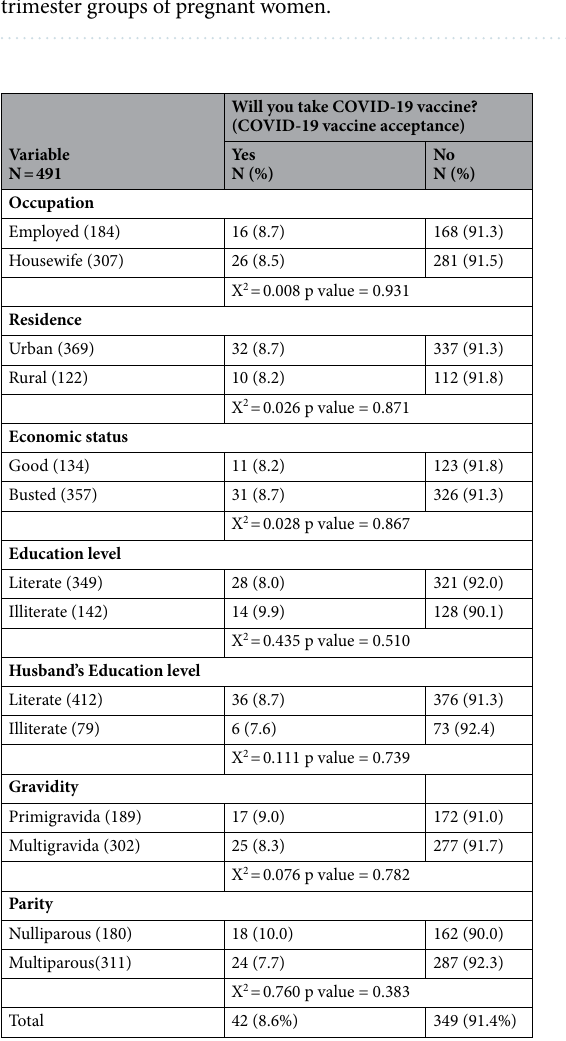
Figure 4. The distribution between willingness and refusal to take the COVID-19 vaccine in gestational trimester groups of pregnant women.